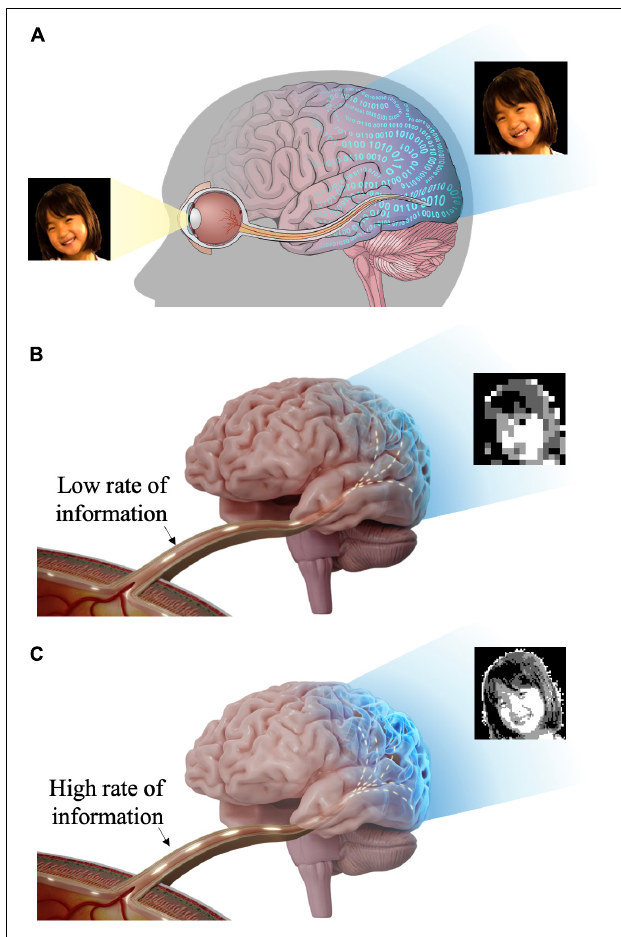
FIGURE 1 | Schematic illustration of visual information transfer from the eye to the visual cortex. The visual information flows through the lateral geniculate nucleus (LGN) en route to the visual cortex. But, LGN is not shown in this figure for brevity. (A) Retinal ganglion cells generate spiking activities to visual stimuli and transmit visual information to the brain (visual cortex) through the optic nerve and optic radiation. (B) Insufficient visual information and less natural artificial vision may activate higher visual centers inappropriately. (C) Rich visual information and more natural artificial vision may activate higher visual centers more